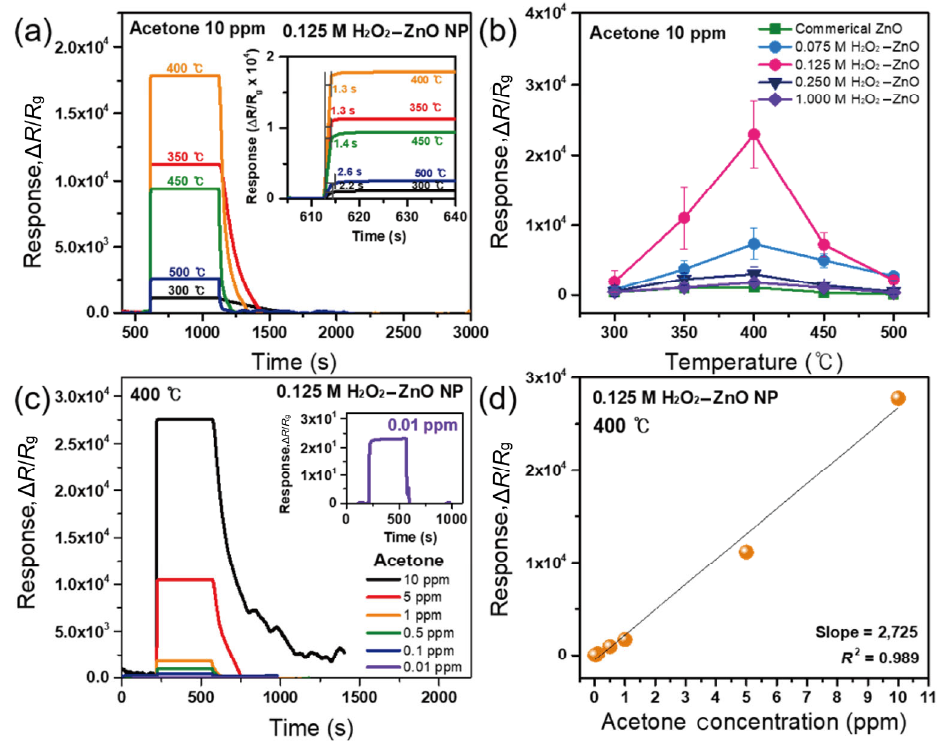
Fig. 5 (a) Variation in the response of 0.125 M H 2 O 2 treated/annealed ZnO NPs to 10 ppm acetone in the operating temperatures of 300, 350, 400, 450, and 500 . The inset depicts response time from their sensing curves ℃ . (b) Maximum sensing response of commercial ZnO NPs and x M H 2 O 2 treated/annealed ZnO NPs ( x = 0.075, 0.125, 0.250, and 1.000) at 10 ppm acetone as a function of operating temperature. (c) Variation in the response of the 0.125 M sample at an optimum operating temperature (400 ) as a function of acetone concentration. (d) Sensing response of 0.125 M sample to different ℃ concentrations of acetone in 0.01, 0.1, 0.5, 1, 5, and 10 ppm at 400 . Sensitivity was calculated from a slope of a linear fit of ℃ the